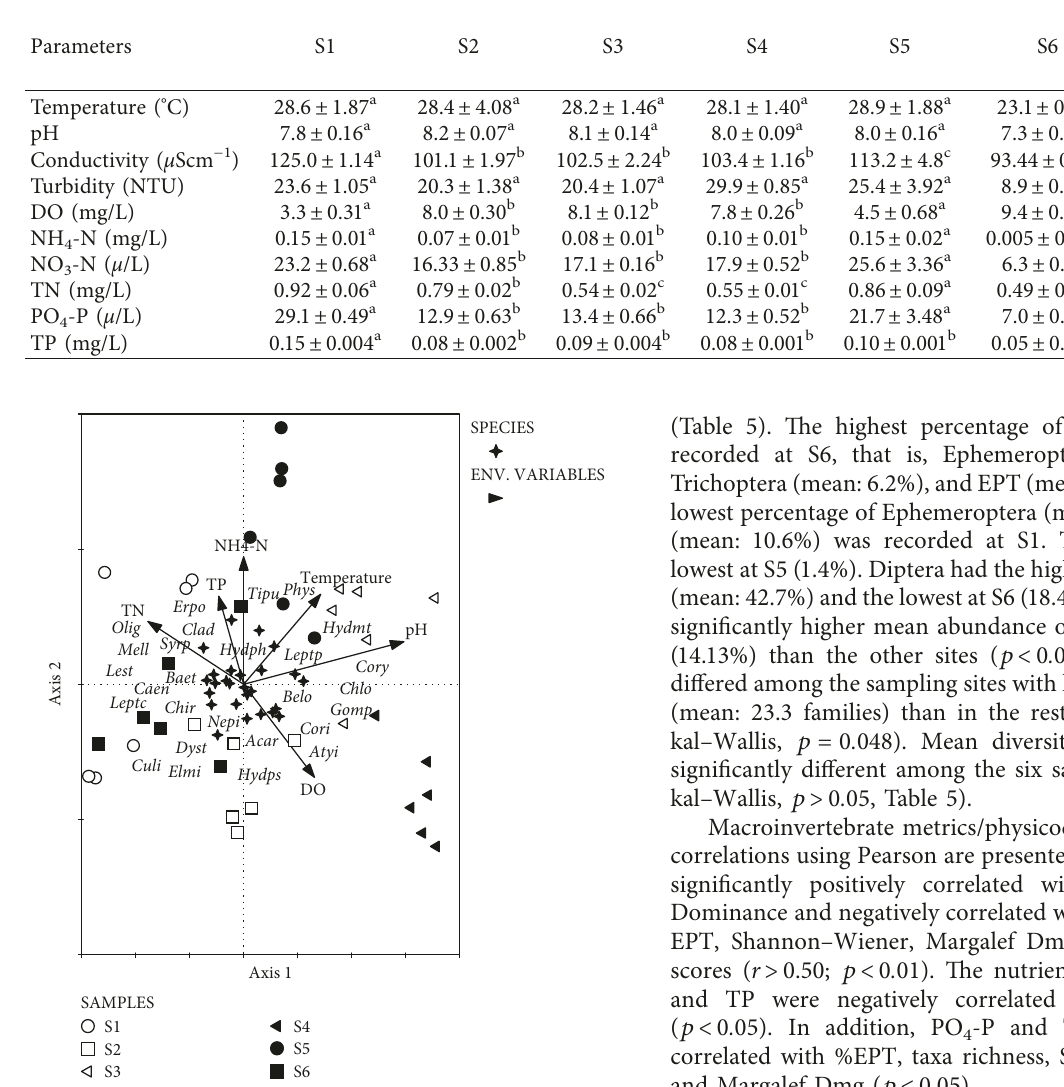
Figure 2: Canonical correspondence analysis (CCA) triplot for the relationship between macroinvertebrates assemblage and physi- cochemical variables at the six sampling sites in Sanyati basin, Lake Kariba, between January and March